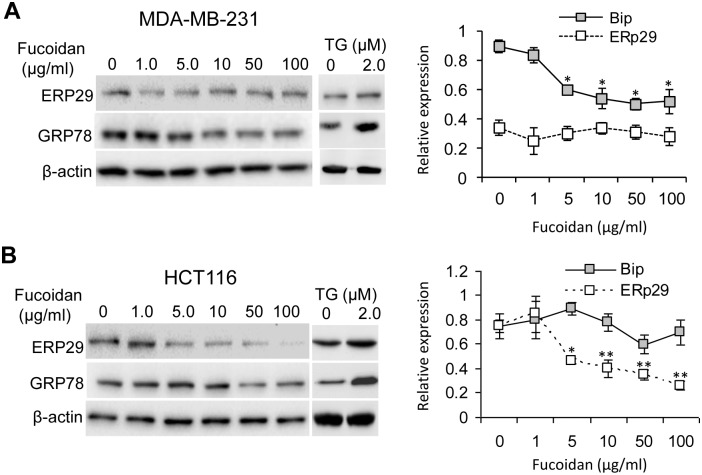
Effect of fucoidan on the expression GRP78 and ERp29.Cells at 70–80% confluence were treated with fucoidan at the indicated concentrations for 3 days and both the attached and suspended cells were harvested for protein expression analysis. (A) The expression of GRP78, but not ERp29, was inhibited by fucoidan in MDA-MB-231 cells; (B) The expression of ERp29 was significantly attenuated by fucoidan in HCT116 cells, while GRP78 was only slightly decreased (∼1.5-fold) in cells treated with fucoidan at >50 µg/ml. As a positive control, cells were treated with ER stress inducer TG (2.0 µM) for 24 h. Data represent mean ± SD in triplicate experiments. *p<0.05; **p<0.01.